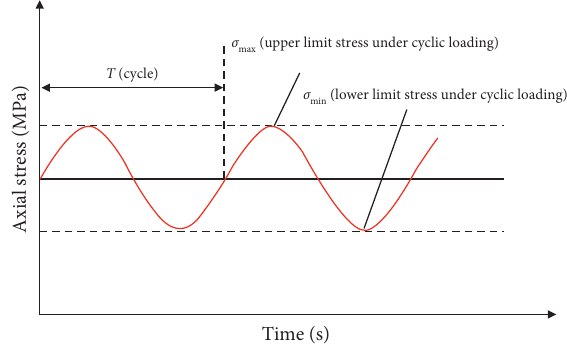
Figure 6: Diagram of cyclic loading